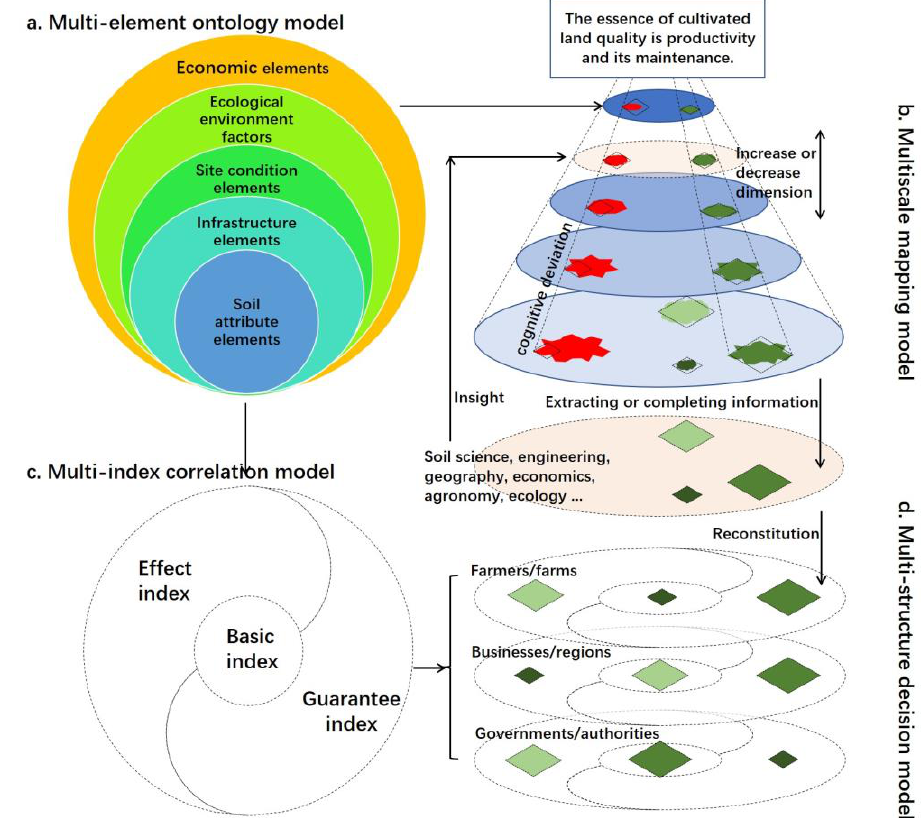
Figure 1. Cognitive conceptual model of cultivated land quality based on the data perspective. ( a ) Circles of different colors represent the different components of the cultivated land. The bottom-up range is getting larger and larger. ( b ) Circles of different colors represent different scales. The smaller the circle, the larger the scale. The figures in the circle represent the elements of cultivated land. As the scale decreases, the elements of cultivated land from the perspective of different disciplines become clearer. ( c ) Basic index is the key of effect index and guarantee index. ( d ) Three circles represent different scenes, in which the order of graphic position represents the different roles of farmland elements in different